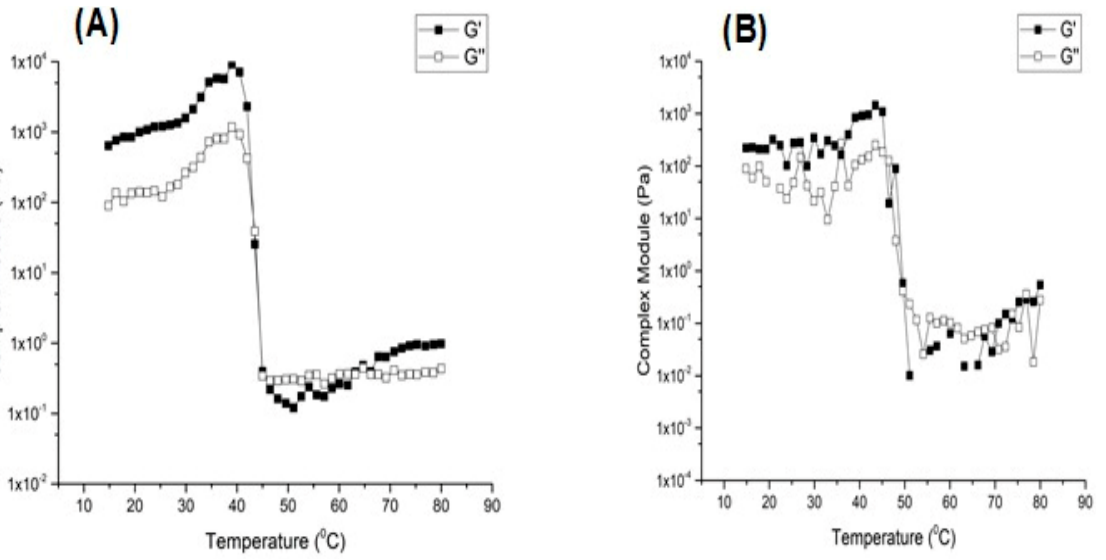
Figure 7. Complex module of OG ( A ) and OG + HA ( B ).